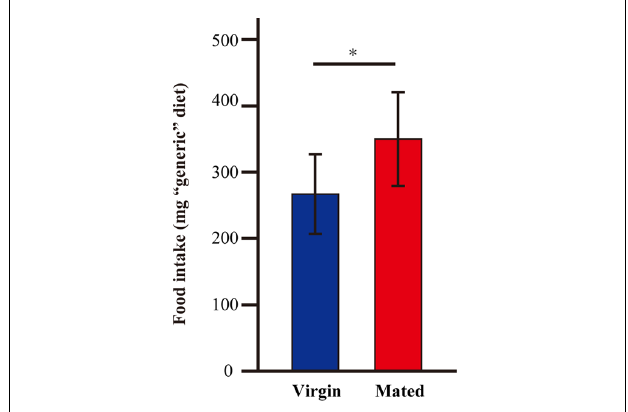
FIGURE 2 | The amount of “generic” diet intake after mating in G. bimaculatus females. The amount of food intake by G. bimaculatus adult females after mating was measured by consumption of two different “generic” diet tablets: carbohydrate-rich and protein-rich tablets. The amount of food intake by the mated females was measured and was compared with the amount of food intake by the virgin females. N = 7, Mean ± SD . Data was statistically analyzed by Student’s t- test. P -values less than 0.05 were considered to be statistically significant. ∗ P < 0 .